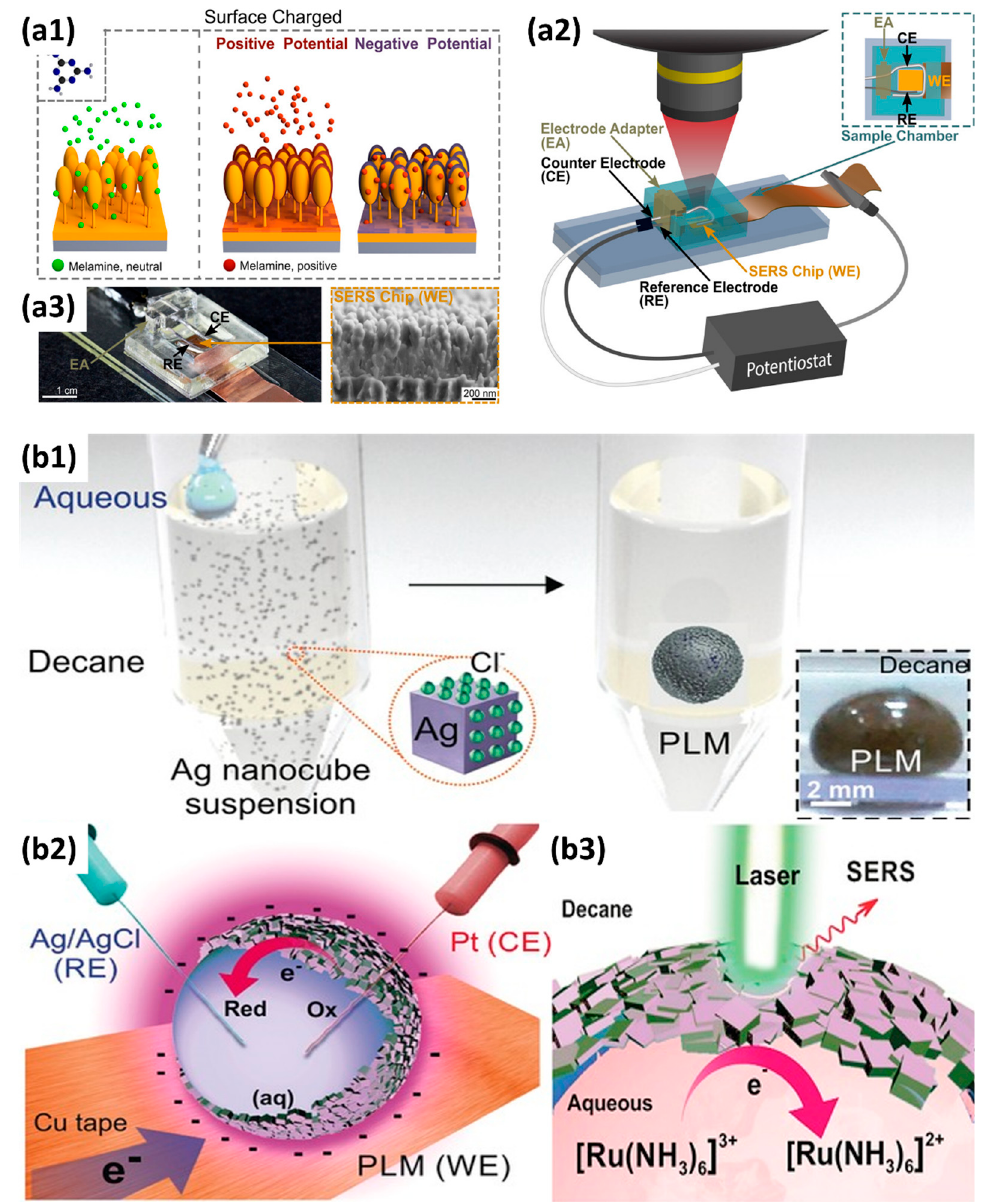
Figure 5. ( a1 ) Schematic diagram of the electrochemically assisted SERS-based detection working principle. ( a2 ) Illustration of the custom-made electrochemical-SERS platform and its respective system interfacing. ( a3 ) Photo of the assembled detection chamber and SEM image of Au-capped nanopillar structures for SERS detection. Reprinted from [17], with permission from ACS Publications. ( b1 ) Fabrication of PLM. Inset: digital image of PLM. ( b2 ) Using the Ag shell as a 3D working electrode (WE). ( b3 ) Electrochemistry-SERS investigation using PLM. Reprinted from [20], with permission from John Wiley and Sons.